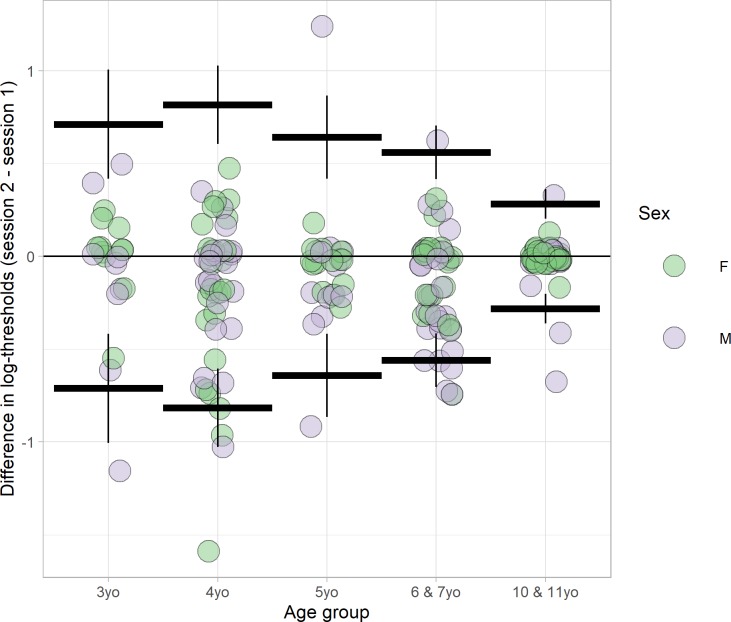
Differences in Preschool Randot thresholds (second session minus first session) are plotted by age-group for 182 children.The thick horizontal lines show the 95% limits of reliability for the 5 age-groups; the vertical lines show the estimated 95% confidence interval on this limit.